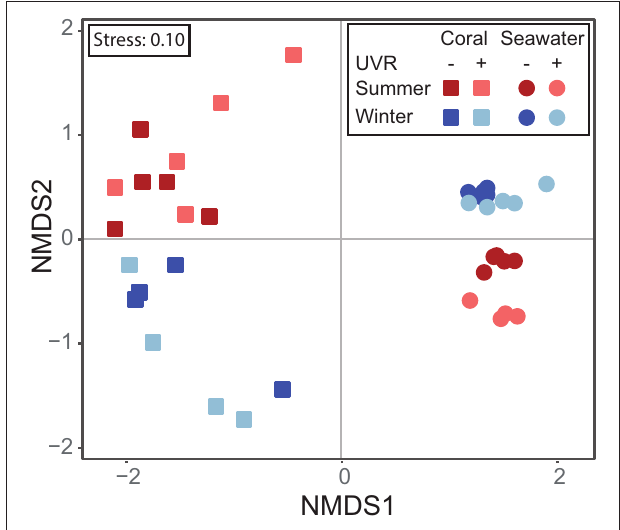
FIGURE 3 | Non-Metric Dimensional Scaling (nMDS) plot showing the (1) seasonal differences in the beta diversity of the coral microbiota, (2) seasonal changes in the beta diversity in seawater microbial communities, and (3) the effect of UVR on the beta diversity in seawater microbial communities at both